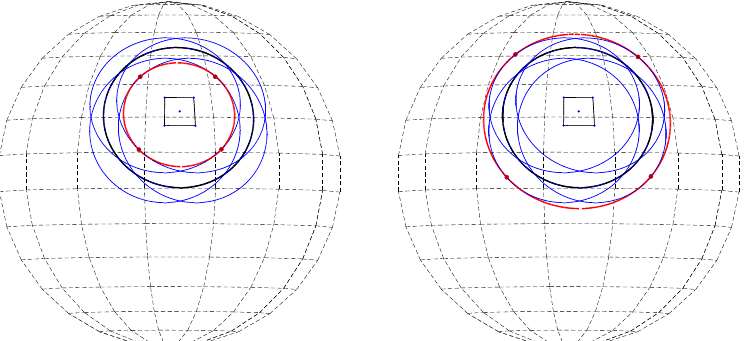
Figure 13. ( Left ) The four critical points (red) closer to the cell center and the (higher) critical circle they define. ( Right ) The four critical points (red) more distant from the cell center and the (lower) critical circle they